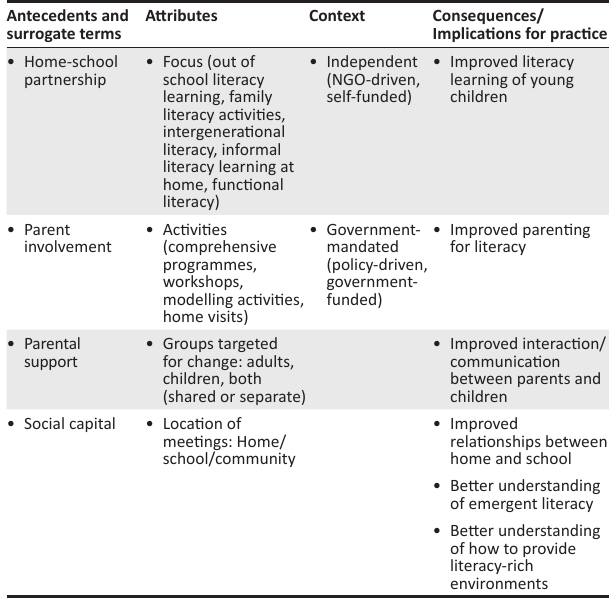
TABLE 1: Analysis of family literacy programmes according to Rodgers’